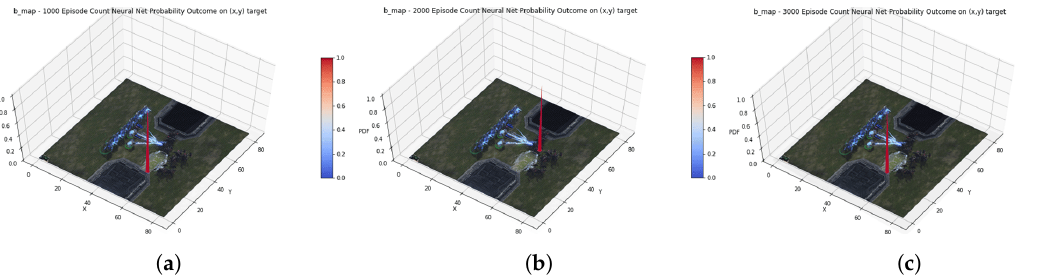
Figure 8. Probability Density Functions (PDF) of global network for ‘( a ) Choke Playing’ Scenario each describing ( a ) 300 episodes, ( b ) 800 episodes, and ( c ) 1000 episodes, respectively.